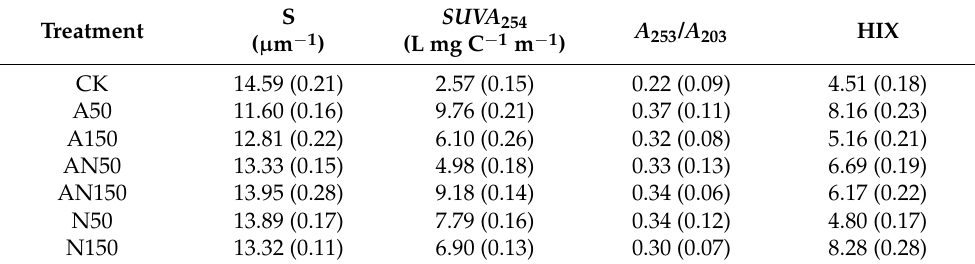
Figure 3. UV-vis spectra of DOM extracted from temperate forestry soil samples under different treatment. A, (NH 4 ) 2 SO 4 ; AN, NH 4 NO 3 ; N, NaNO 3 . 50, 50 kg N ha −1 year −1 ; 150, 50 kg N ha −1 year −1 . Table 5. The average values of characterization parameters calculated by UV-vis and EEM spectral data ( n = 21).